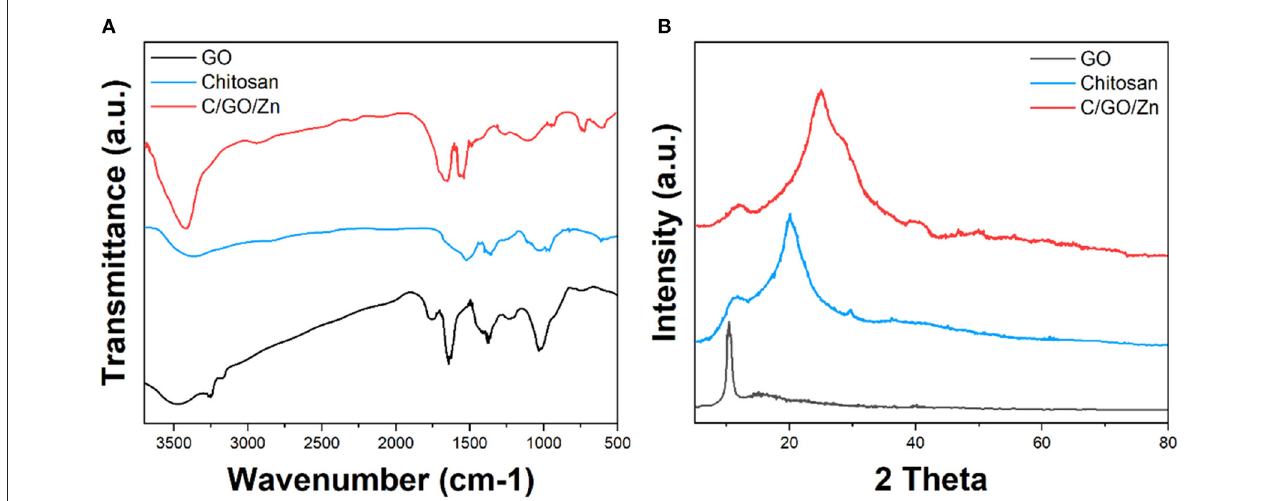
FIGURE 1 | (A) FTIR spectra and (B) XRD patterns of GO, chitosan, and